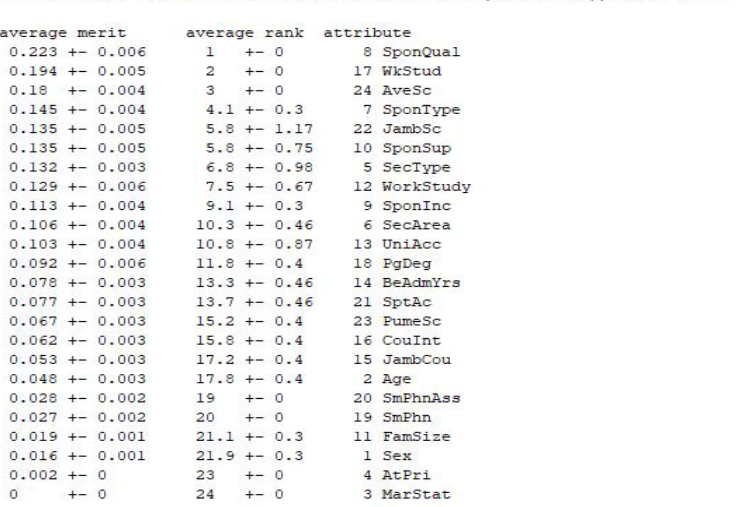
Figure 14: Results from information gain feature selection technique